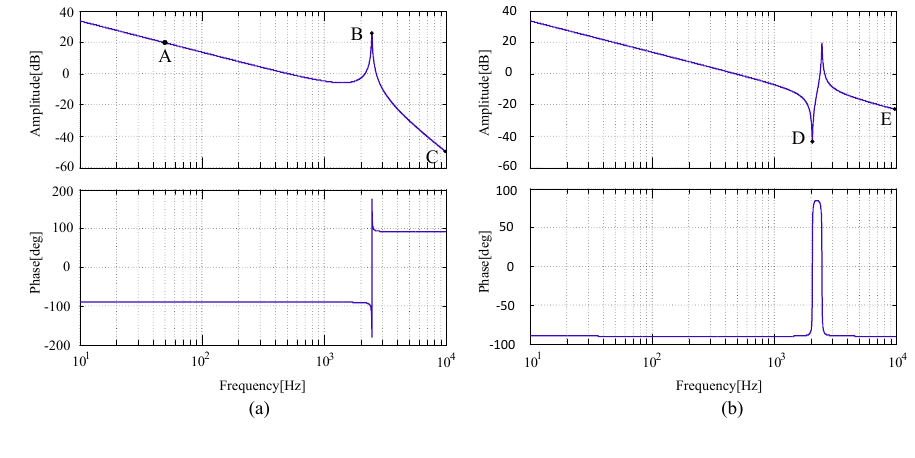
Figure 7. Bode diagrams ( a ) I